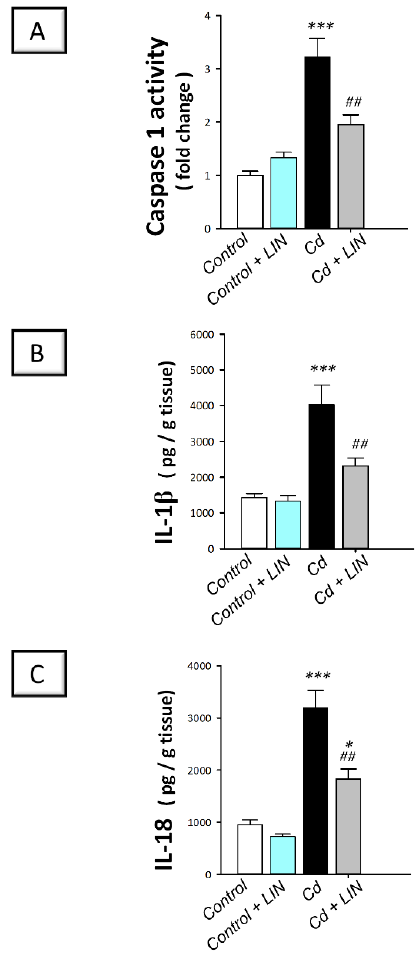
Figure 6. Effect of cadmium and/or linagliptin administration on the testicular caspase ‐ 1/IL ‐ 1 β /IL ‐ 18 pathway in rats. The co ‐ treatment with linagliptin inhibited the testicular caspase ‐ 1/IL ‐ 1 β /IL ‐ 18 pathway that was stimulated by cadmium metal. This was demonstrated by diminished caspase 1 activity ( A ) together with lowered levels of interleukin 1 beta (IL ‐ 1 β ; ( B )), and interleukin 18 (IL ‐ 18; ( C )). * p < 0.05, and *** p < 0.001 show statistical significance compared to the group of control rats; ## p < 0.01 show statistical significance compared to the group of cadmium ‐ intoxicated rats. Values are stated as the mean ± standard error of the mean for 6 animals per group. LIN, linagliptin; Cd, cadmium